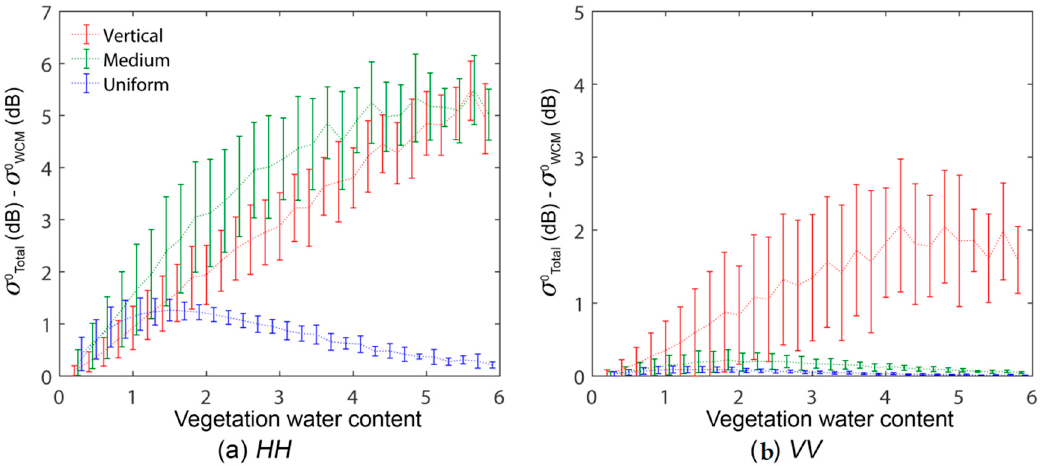
Figure 13. Prediction errors of the WCM defined by the difference the total backscattered signal and the WCM estimation at ( a ) HH- and ( b ) VV-polarizations, as a function of the incidence angle.